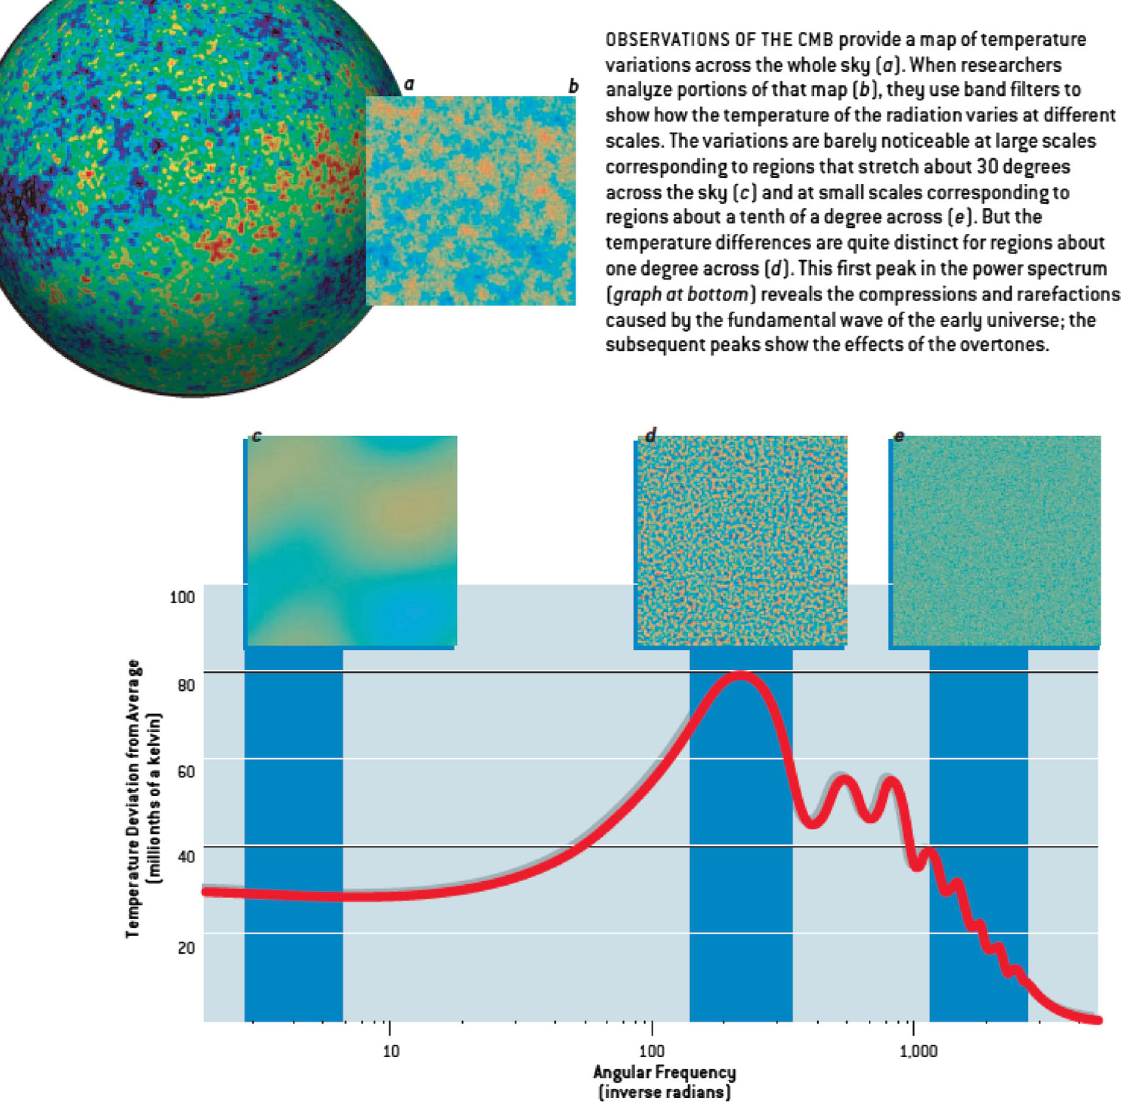
FIG. 36. Power spectrum of the cosmic microwave background, as seen in a popular science article. Image credit: Hu and White